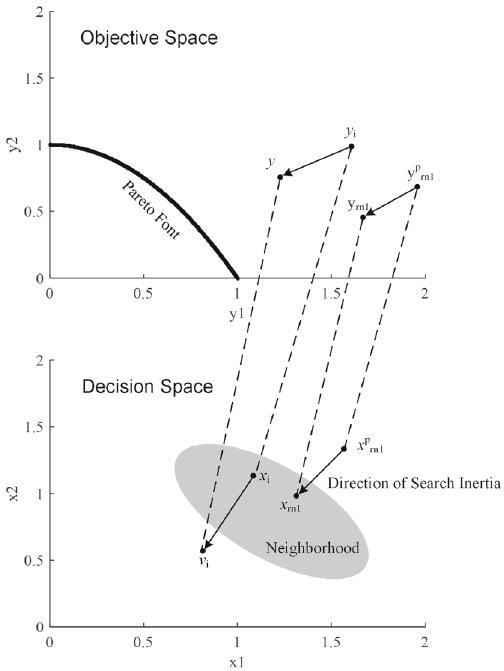
Fig. 2 Procedure of SiDE mutation and the relationship between the parents. Both objective functions are